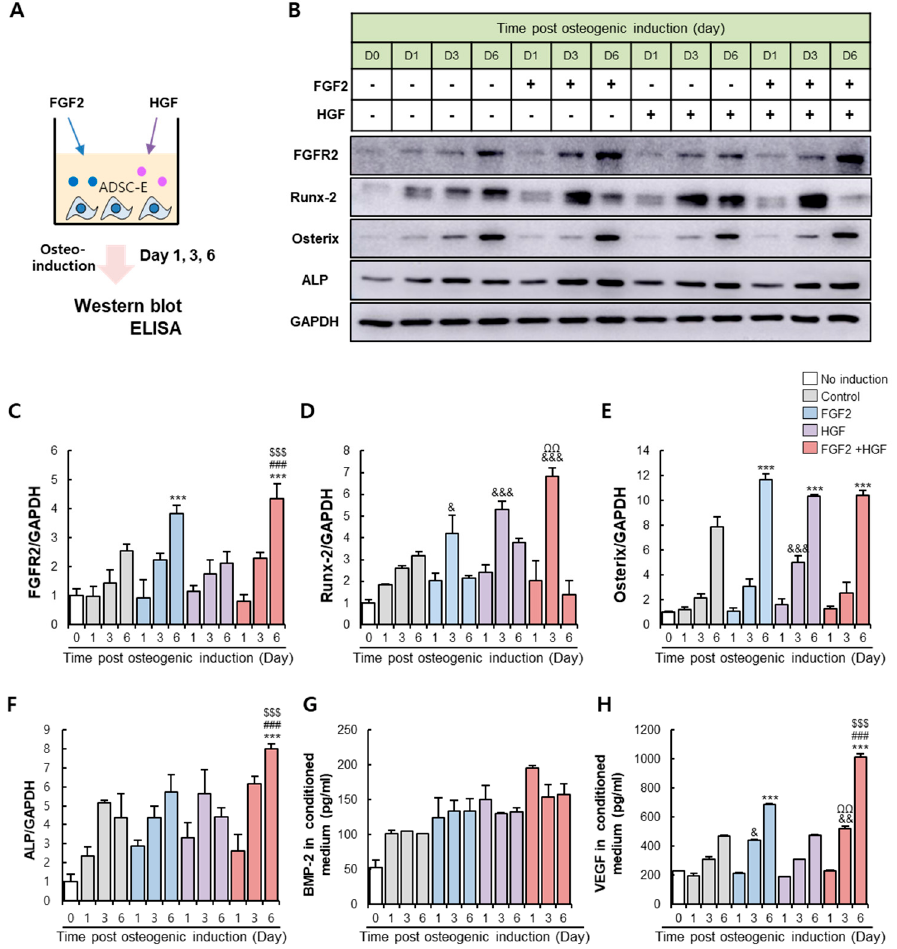
Figure 4. FGF-2 and HGF priming regulate the expression of early osteogenic markers in ADSC-E under osteogenic conditions. ( A ) Experimental scheme for analyzing the effect of FGF-2 and/or HGF priming on osteogenic markers on ADSC-E. ( B – F ) FGFR2, Runx-2, Osterix, and ALP levels in ADSC-E were examined by western blot. ( G , H ) Quantification of BMP-2 and VEGF in a conditioned medium was performed by ELISA. Results are shown as the mean ± SD of five replicate wells for each group. & p < 0.05, && p < 0.01, &&& p < 0.001 vs. Day 3 of control, ΩΩ p < 0.01 vs. Day 3 of HGF-primed ADSC-E, *** p < 0.001 vs. Day 6 of control, ### p < 0.001 vs. Day 6 of FGF2-primed